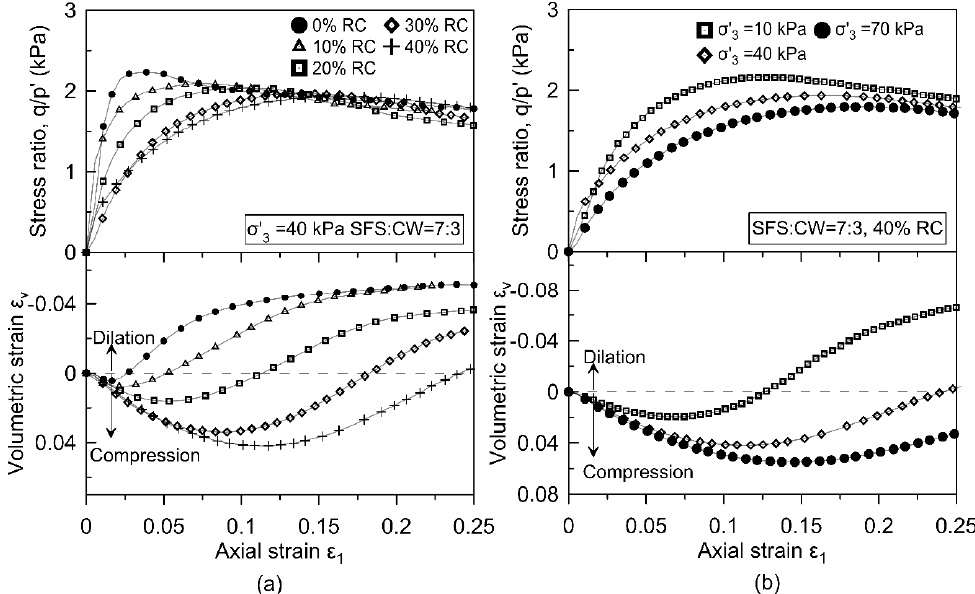
Figure 2. Stress-strain curves of SFS+CW+RC mixtures: ( a ) having different RC contents under 𝜎′ (cid:2871) = 40 𝑘𝑃𝑎 ; ( b ) having 40% RC under different 𝜎′ (cid:2871) .